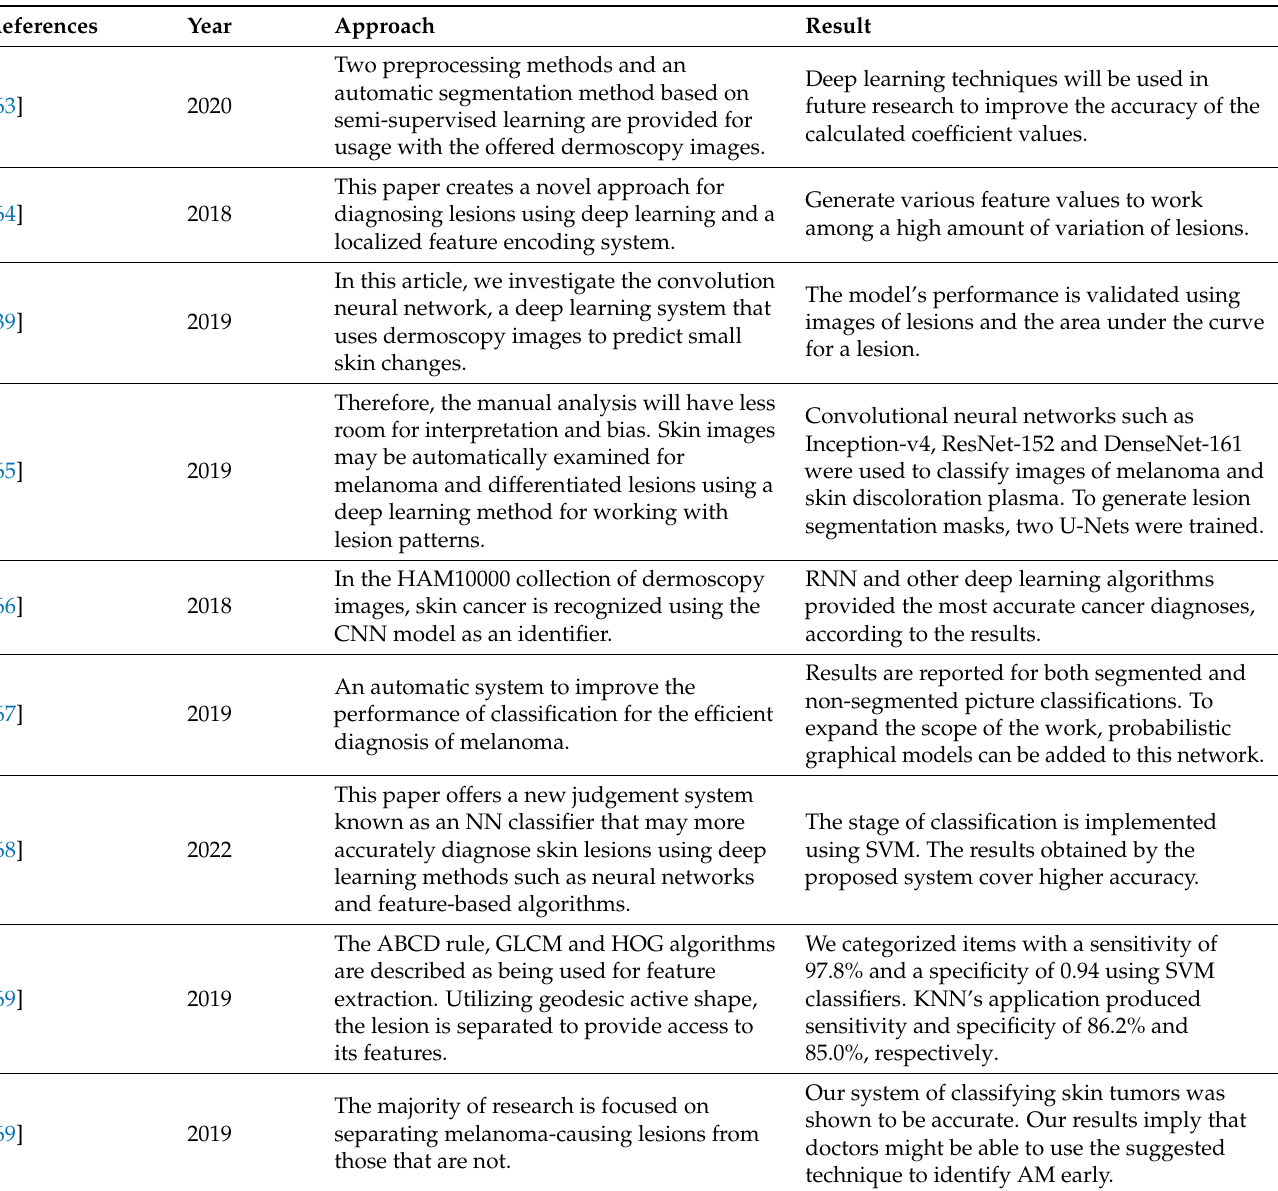
Table 10. Machine learning and deep learning